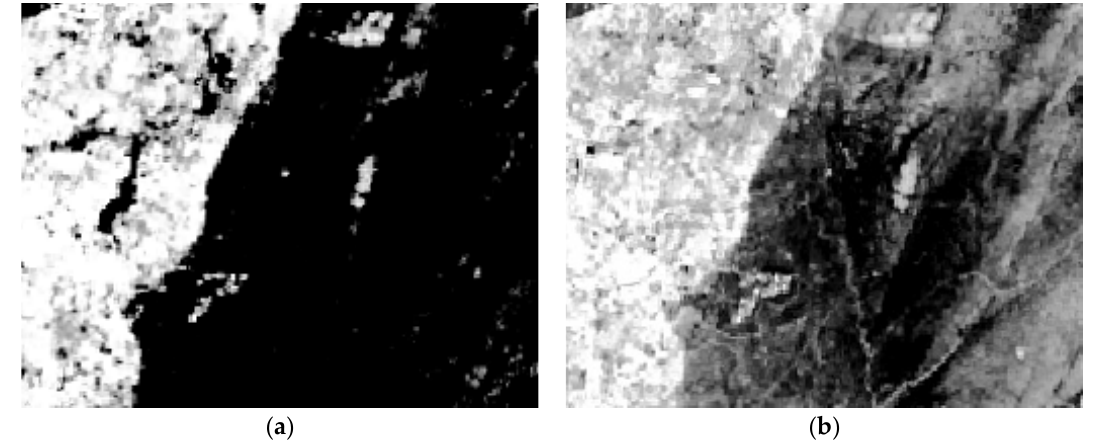
Figure 3. Preprocessed Landsat TIRS bands of Javadi Hill for the years ( a ) 2012 and ( b ) 2015.